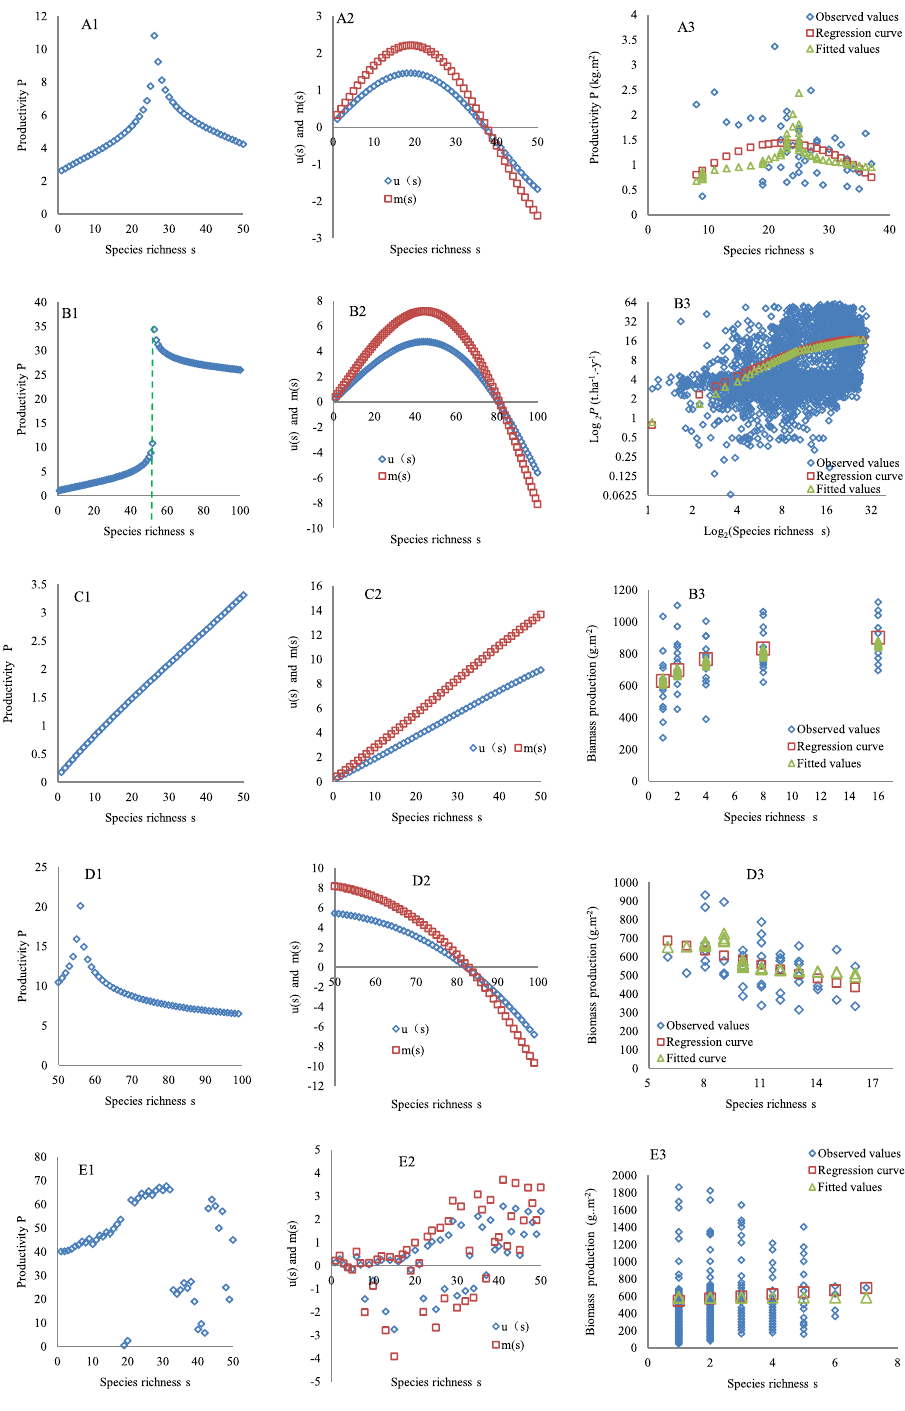
Figure 2. Forms of the SRPR. ( A1 – E1 ) represent the humped, asymptotic, positive, negative, and irregular forms, respectively. ( A2 – E2 ) show the dynamics of the SC effects ( u (s)) and density effect ( m (s)) for the five forms. ( A3 – E3 ) show the observed productivity along a species richness gradient in the grasslands of Texas 67 , forest plots around the world 56 , the floodplain of the Saale River in Germany 10 , and the plant community in Gloucestershire of the UK 59,68 , respectively. The regression curve was fitted based on the observed productivity. Fitted curves were drawn using the predicted productivity (obtained using the third value in each cell in the data columns marked with # in Supplemental Table 1 being substituted into Eq.